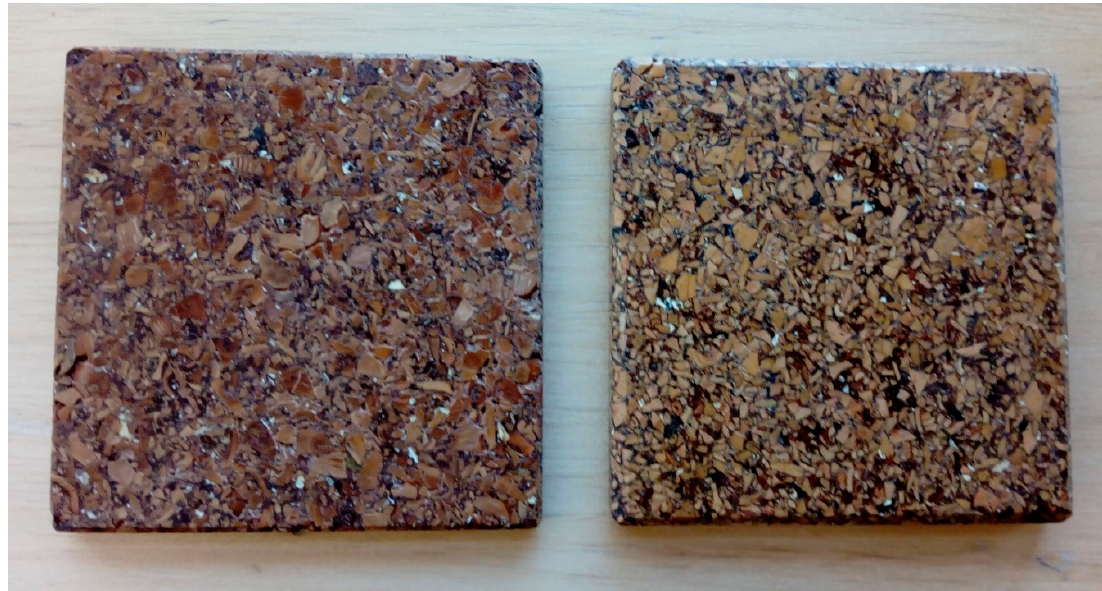
Figure 1. Hazelnut and walnut 10 mm thick samples bonded with PUR; 1000 kg/m 3 density; Figure1. Hazelnutandwalnut10mmthicksamplesbondedwithPUR;1000kg / m 3 density; composition: 70% fine-grained particles ( < 3 mm) and 30% coarse-grained particles (3–6